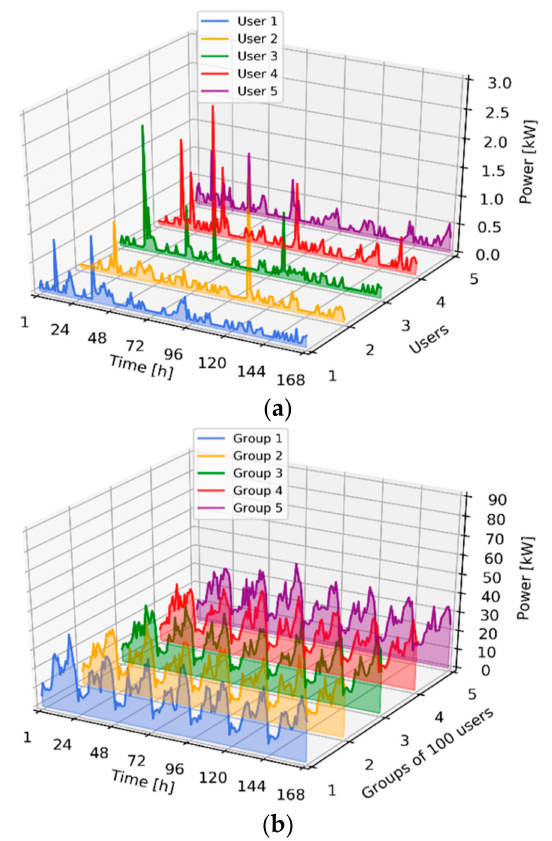
Figure 4. Load profiles for one week of the year for different groups of: ( a ) 1 residential household and ( b ) 100 residential